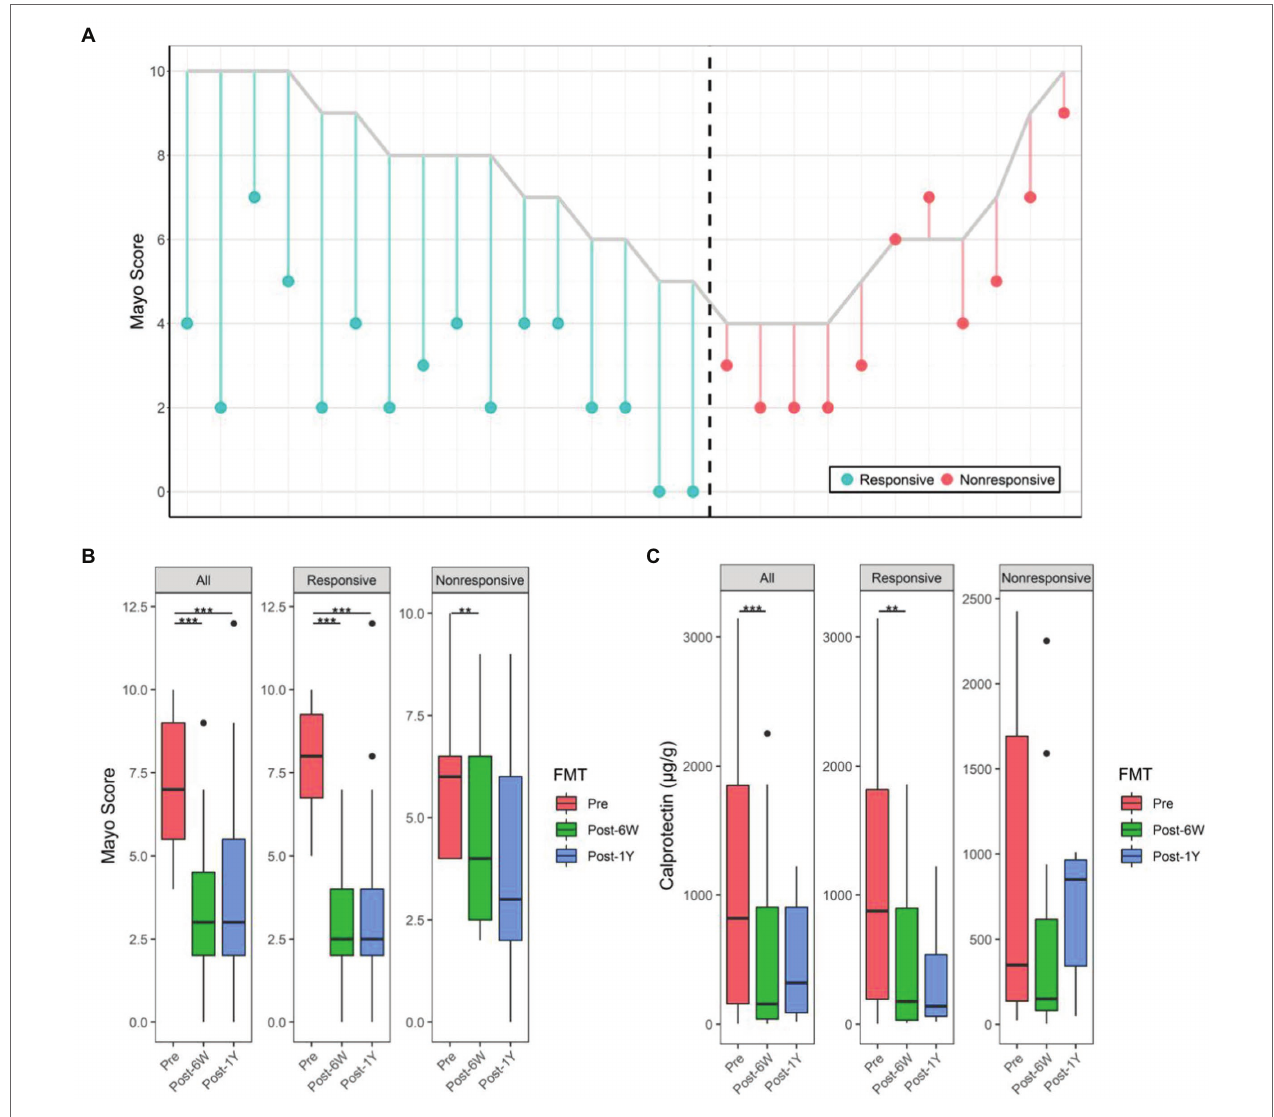
FIGURE 2 | Alterations of full Mayo score and calprotectin. (A) Change of full Mayo score of all patients 6 weeks after FMT. The vertical parallel line plot shows changes in Mayo score for each individual patient. For each patient who received FMT, the line starts at his/her pre-FMT full Mayo score and ends at his/her FMT full Mayo score 6 weeks after FMT. The color shows the response of each patient. (B) The Mayo score of patients before, 6 weeks after, and 1 year after FMT. (C) The calprotectin levels of patients before, 6 weeks after, and 1 year after FMT. Boxplots present the median and interquartile range (25–75th percentiles) for each group with whisker length equal to 1.5 interquartile range. The colors show the group of patients. Statistically significances are also indicated: ** p < 0.01, *** p <